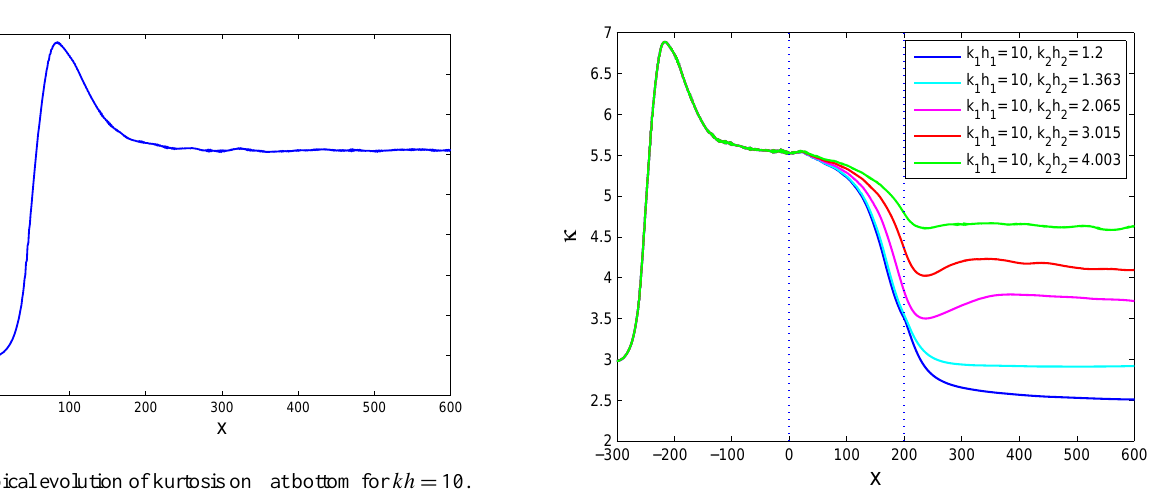
Fig. 6. Kurtosis as a function of x for k 1 h 1 = 10, k 2 h 2 = 1.2, 1.363, 2.065, 3.015, 4.003 and initial BFI = 1 . 7.